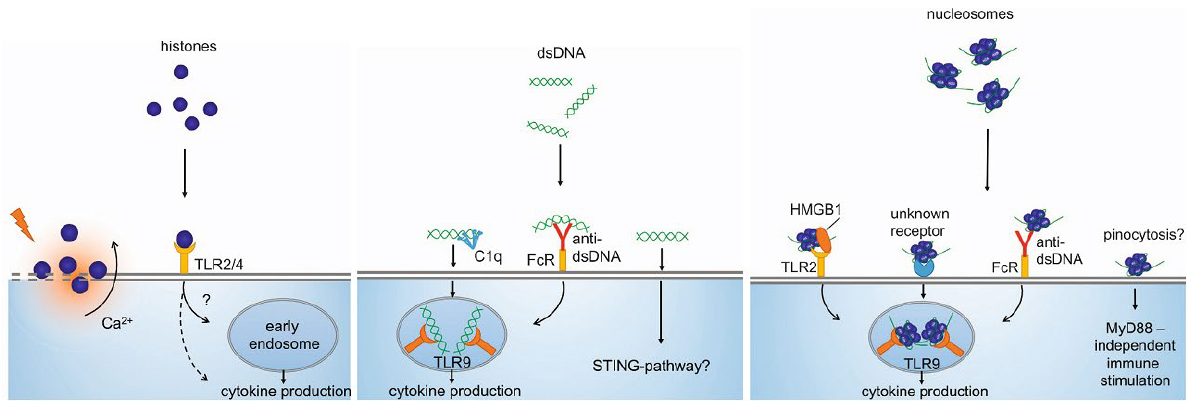
Figure 3. Differences in cirDNA, nucleosome and histone internalization, and their following biological effects. Reprinted with permission from Ref. [72]. Copyright 2016 The Author(s) Published with license by Nature Publishing Group.